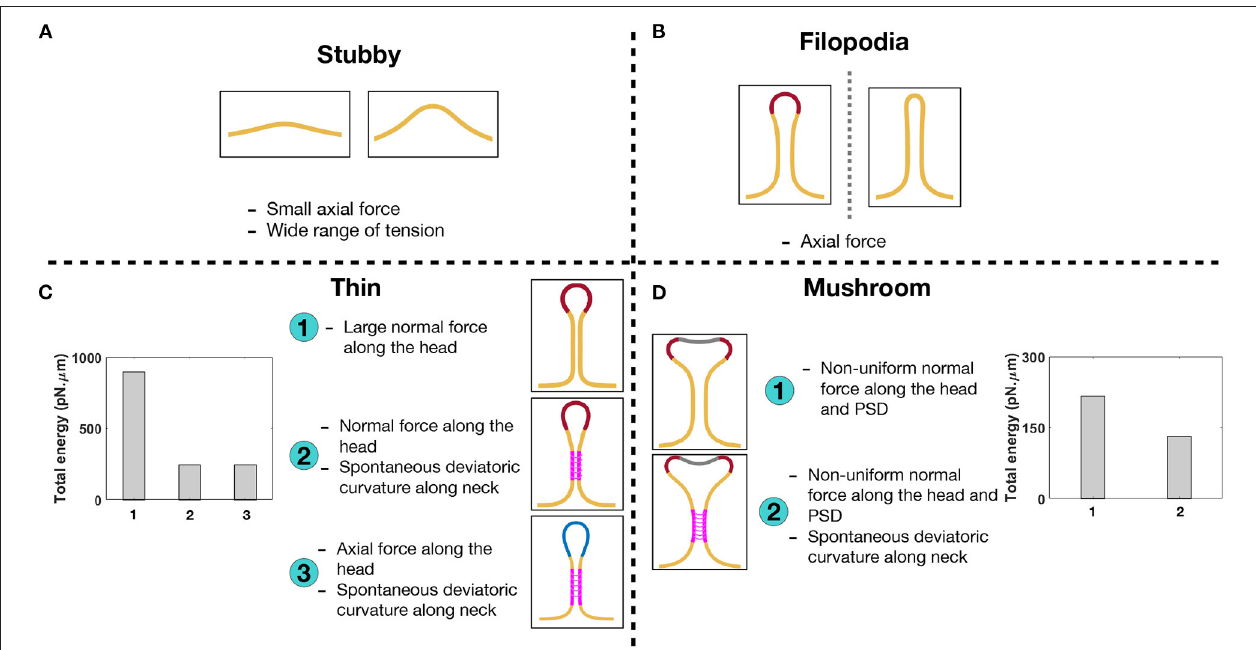
FIGURE 7 | Characterizing different shapes of dendritic spines based on the mechanical model. (A) Stubby spines can be formed with an axial force and in a wide range of tensions. (B) An axial force is sufficient to form a long filopodial spine. (C) A thin-shaped spine can be formed with three different mechanisms; (1) a uniform normal force density along the spine head, (2) a uniform normal force density along the spine head and spontaneous deviatoric curvature along the neck, and (3) a uniform axial force density along the spine head and spontaneous deviatoric curvature along the neck. In the bar plot, the total energy of the system is shown for three different mechanisms. The total energy of the system for the second and third mechanisms with spontaneous deviatoric curvature is much less than the energy for the first mechanism with just a normal force. (D) A mushroom-shaped spine can be formed with two different mechanisms; (1) a non-uniform normal force density along the spine head and PSD region and (2) a non-uniform normal force density along the spine head and PSD region plus a spontaneous deviatoric curvature along the spine neck. The resulting mushroom spine with a combination of normal forces and spontaneous deviatoric curvature has lower energy compared to the spine that is formed with just normal forces (bar